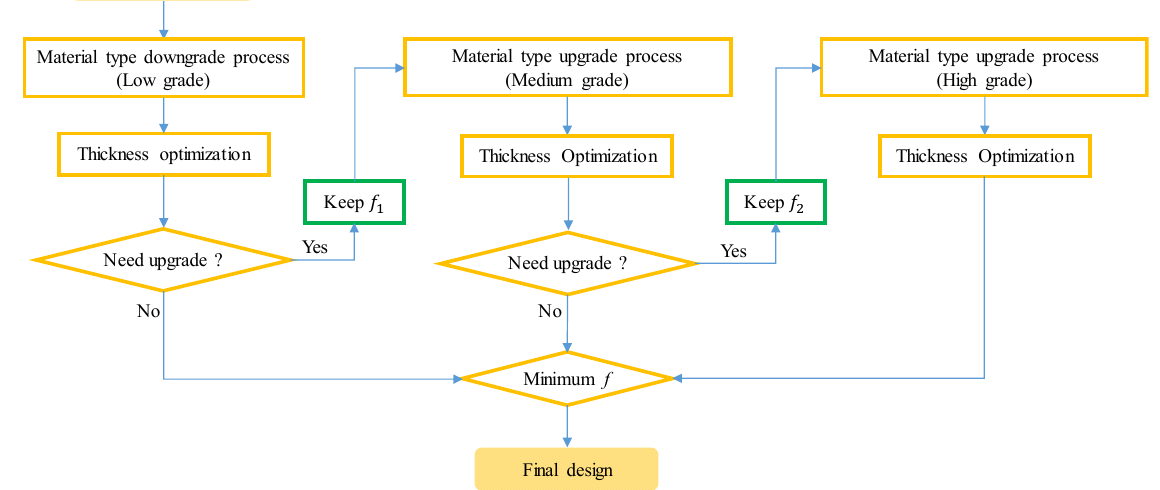
Figure 2. Optimization algorithm.